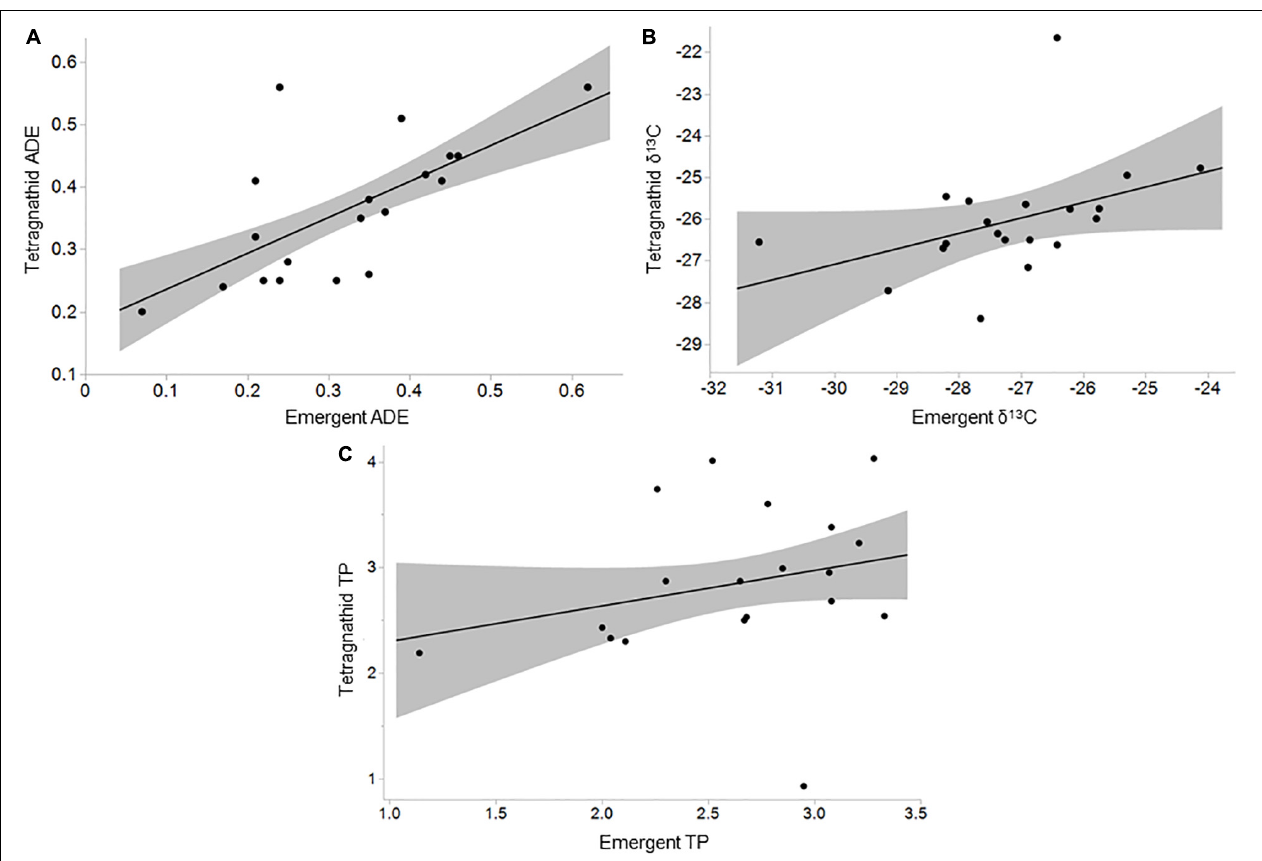
FIGURE 3 | Relationships between (A) emergent aquatic insect aquatically derived energy (ADE) and tetragnathid spider ADE ( R 2 = 0.44, F = 13.59, p = 0.002); (B) emergent aquatic insect and tetragnathid spider δ 13 C ( R 2 = 0.20, F = 4.55, p = 0.047); and (C) emergent aquatic insect trophic position (TP) and tetragnathid spider TP ( R 2 = 0.06, F = 1.16, p = 0.297). Shaded area indicates 95% confidence